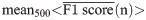
The performance of nEGS-1 with different numbers of non-experts identifying one sleep data.(A) stage N2, (B) stage N3. n is the number of non-experts (n = 1,2,3,…,20). The red square indicates the mean performance of nEGS-1 versus EGS over 500 repetitions (mean500<VS-F1-score(n)>). The shading indicates the standard deviation. The purple circle indicates the mean F1 score of non-experts in nEGS-1 at the optimal thresholds over 500 repetitions (mean500<F1 score¯(n)>). The blue diamond (right ordinate) indicates the difference between the mean500<VS-F1-score(n)> of nEGS-1 and the stable value of the mean performance of the last three values in the red square line (stable value -mean500<VS-F1-score(n)>). The nEGS-1 is the non-expert group standard with definite spindles. The EGS is the expert group standard.